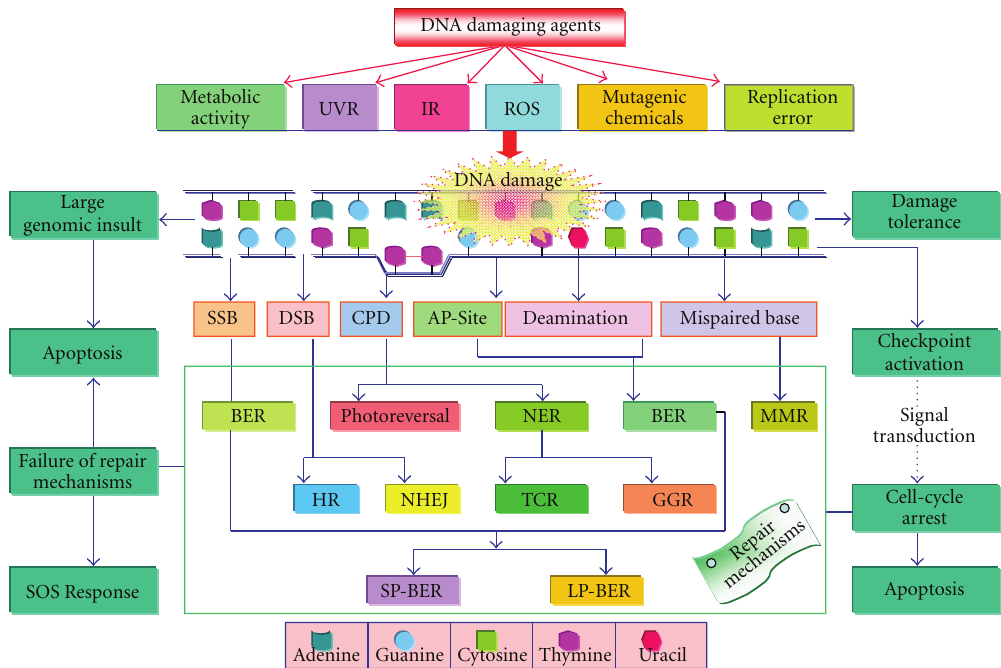
Figure 1: DNA damage and maintenance. Genomic lesions produced by various DNA damaging agents trigger several specific repair machinery to conserve the genomic integrity. In case of severe damage and/or failure of repair mechanisms, cells undergo apoptosis or induce a complex series of phenotypic changes, that is, SOS response. Sometimes the potentiality of lesions in the genome is mitigated by a phenomenon known as damage tolerance, during which DNA lesions are recognized by certain repair machinery, allowing the cells to undergo normal replication and gene expression. The cellular response to DNA damage may activate cell-cycle checkpoint by means of a network of signaling pathway that gives the cell extra time to repair the genomic lesions or may induce cell suicide response/programmed cell death